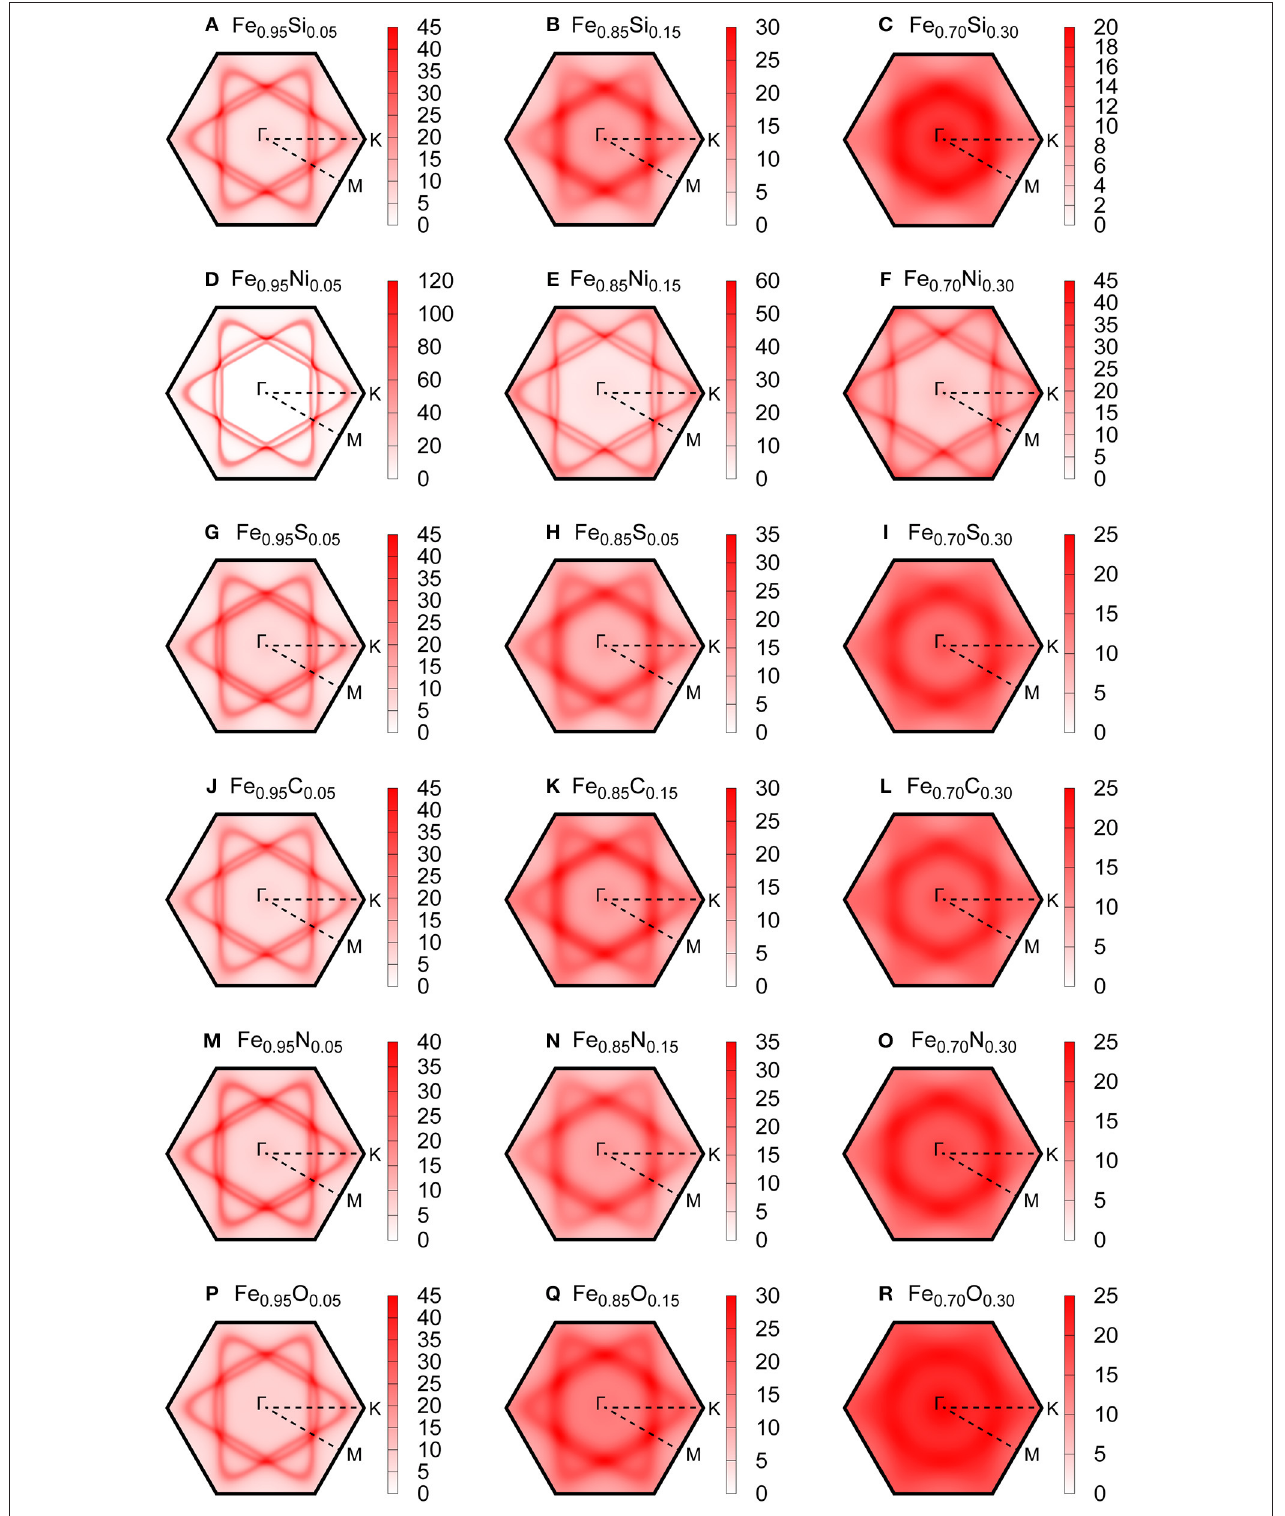
FIGURE 5 | The cross section of the Bloch spectral function at the Fermi energy (Fermi surface) of hcp Fe-based alloys with the volume of 19.10 Å 3 ( ∼ 40 GPa). The compositions are (A) Fe 0.95 Si 0.05 , (B) Fe 0.85 Si 0.15 , (C) Fe 0.70 Si 0.30 , (D) Fe 0.95 Ni 0.05 , (E) Fe 0.85 Ni 0.15 , (F) Fe 0.70 Ni 0.30 , (G) Fe 0.95 S 0.05 , (H) Fe 0.85 S 0.15 , (I) Fe 0.70 Si 0.30 , (J) Fe 0.95 C 0.05 , (K) Fe 0.85 C 0.15 , (L) Fe 0.70 C 0.30 , (M) Fe 0.95 N 0.05 , (N) Fe 0.85 N 0.15 , (O) Fe 0.70 N 0.30 , (P) Fe 0.95 O 0.05 , (Q) Fe 0.85 O 0.15 and (R) Fe 0.70 O 0.30